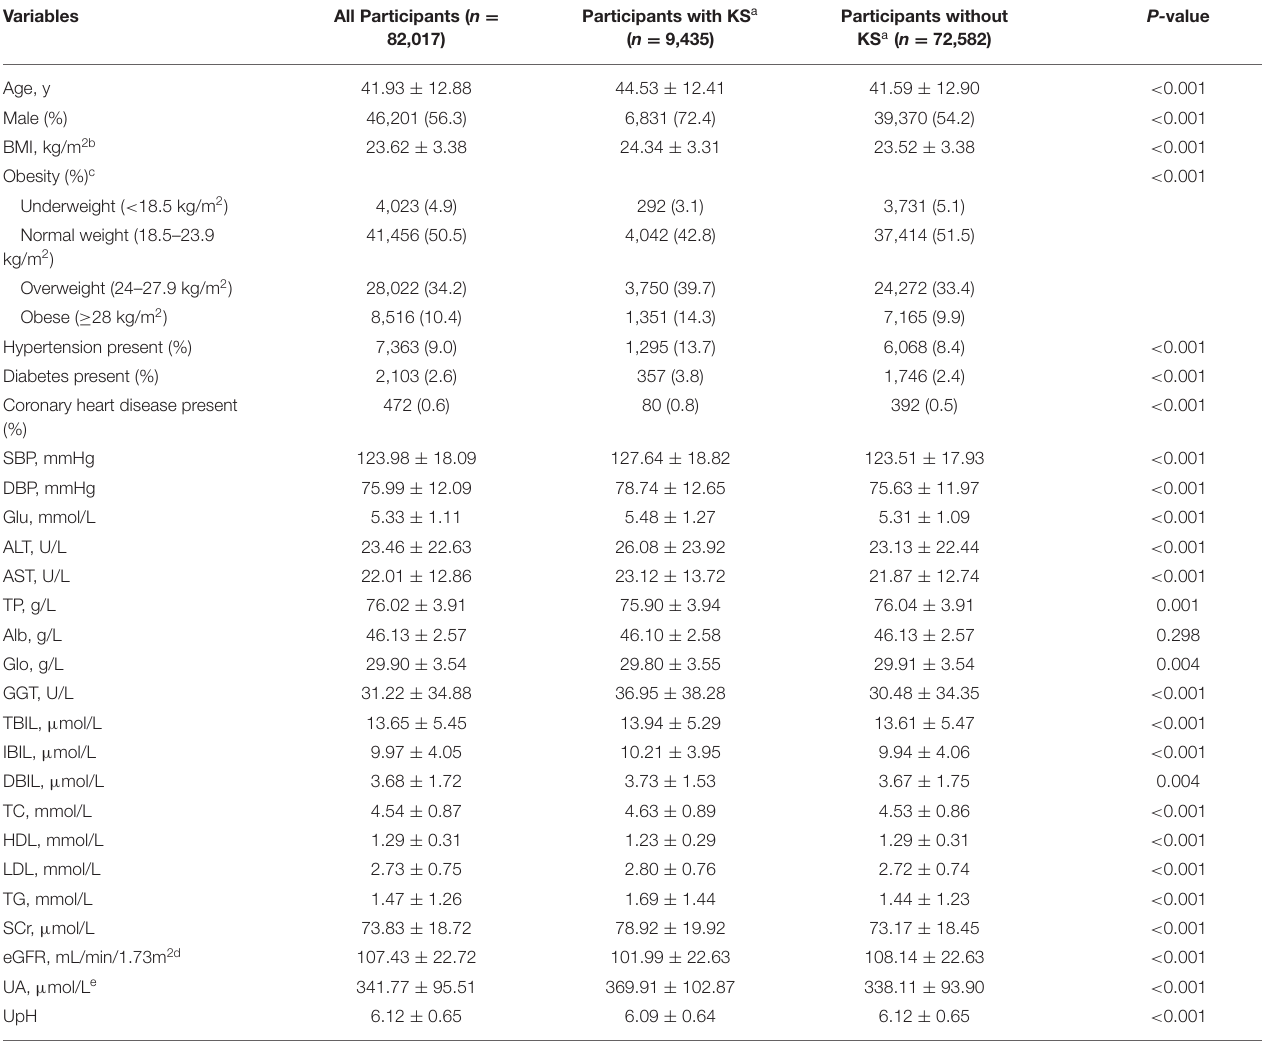
TABLE 1 | Basic characteristics of included participants with or without kidney stone (KS).